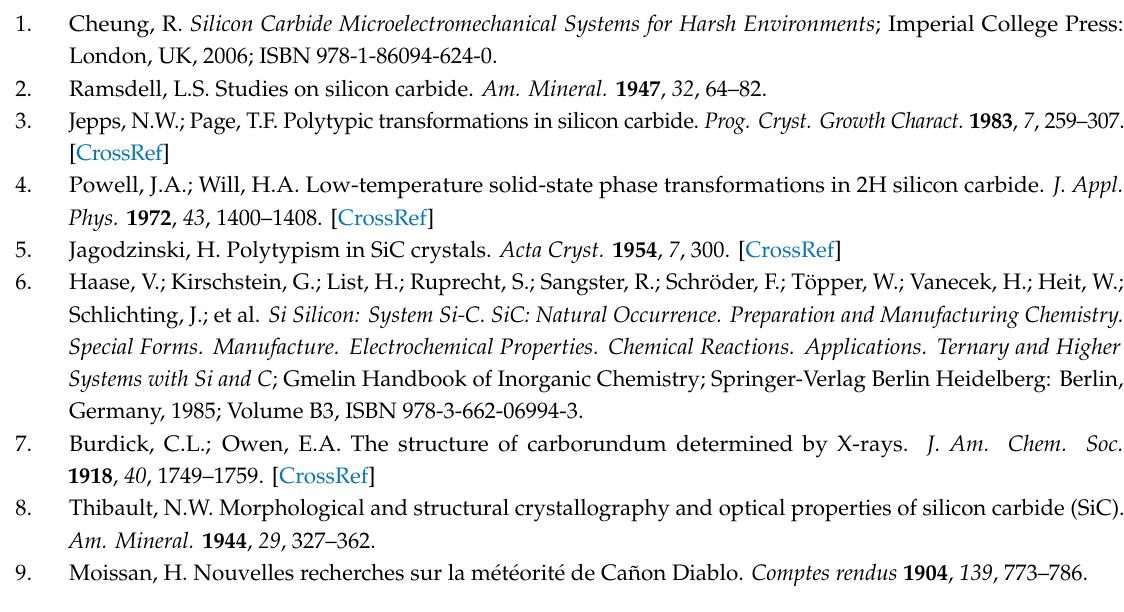
Figure S1: ( a ). Optical microscope image of the tu ffi te sample containing 3 SiC crystals. The red outline indicates the location of the microfossil / microfauna. ( b ). Microfossil / microfauna as seen at larger